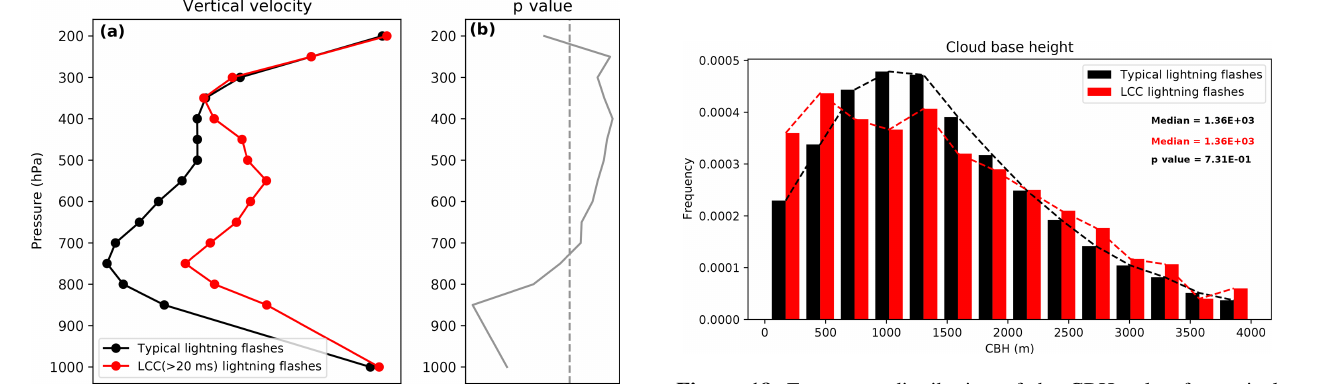
Figure 18. Frequency distribution of the CBH value for typical lightning flashes and for LCC( > 20ms) lightning flashes reported by ISS-LIS over Europe between May and September in 2017–